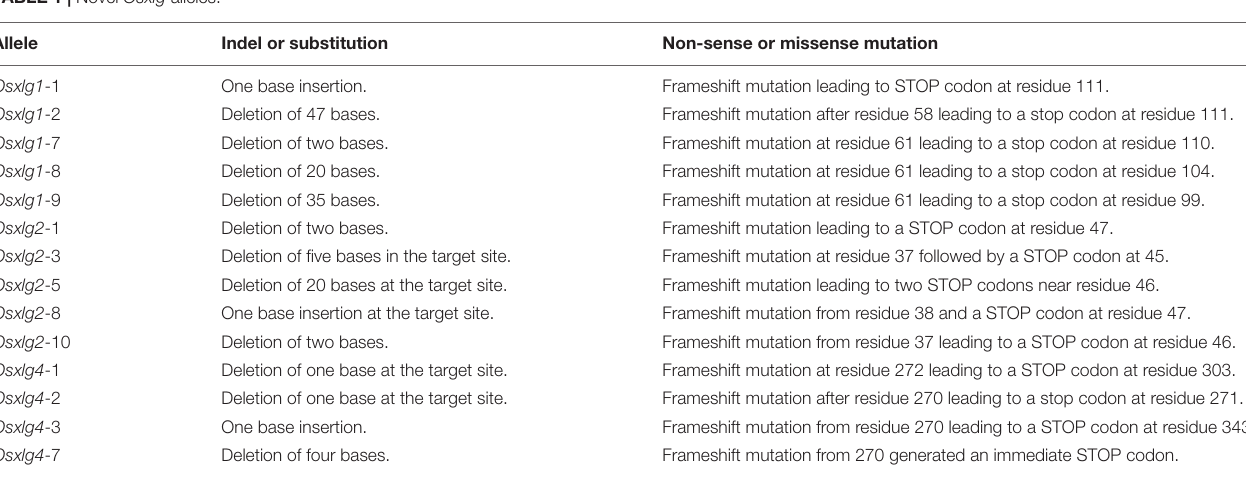
TABLE 1 | Novel Osxlg